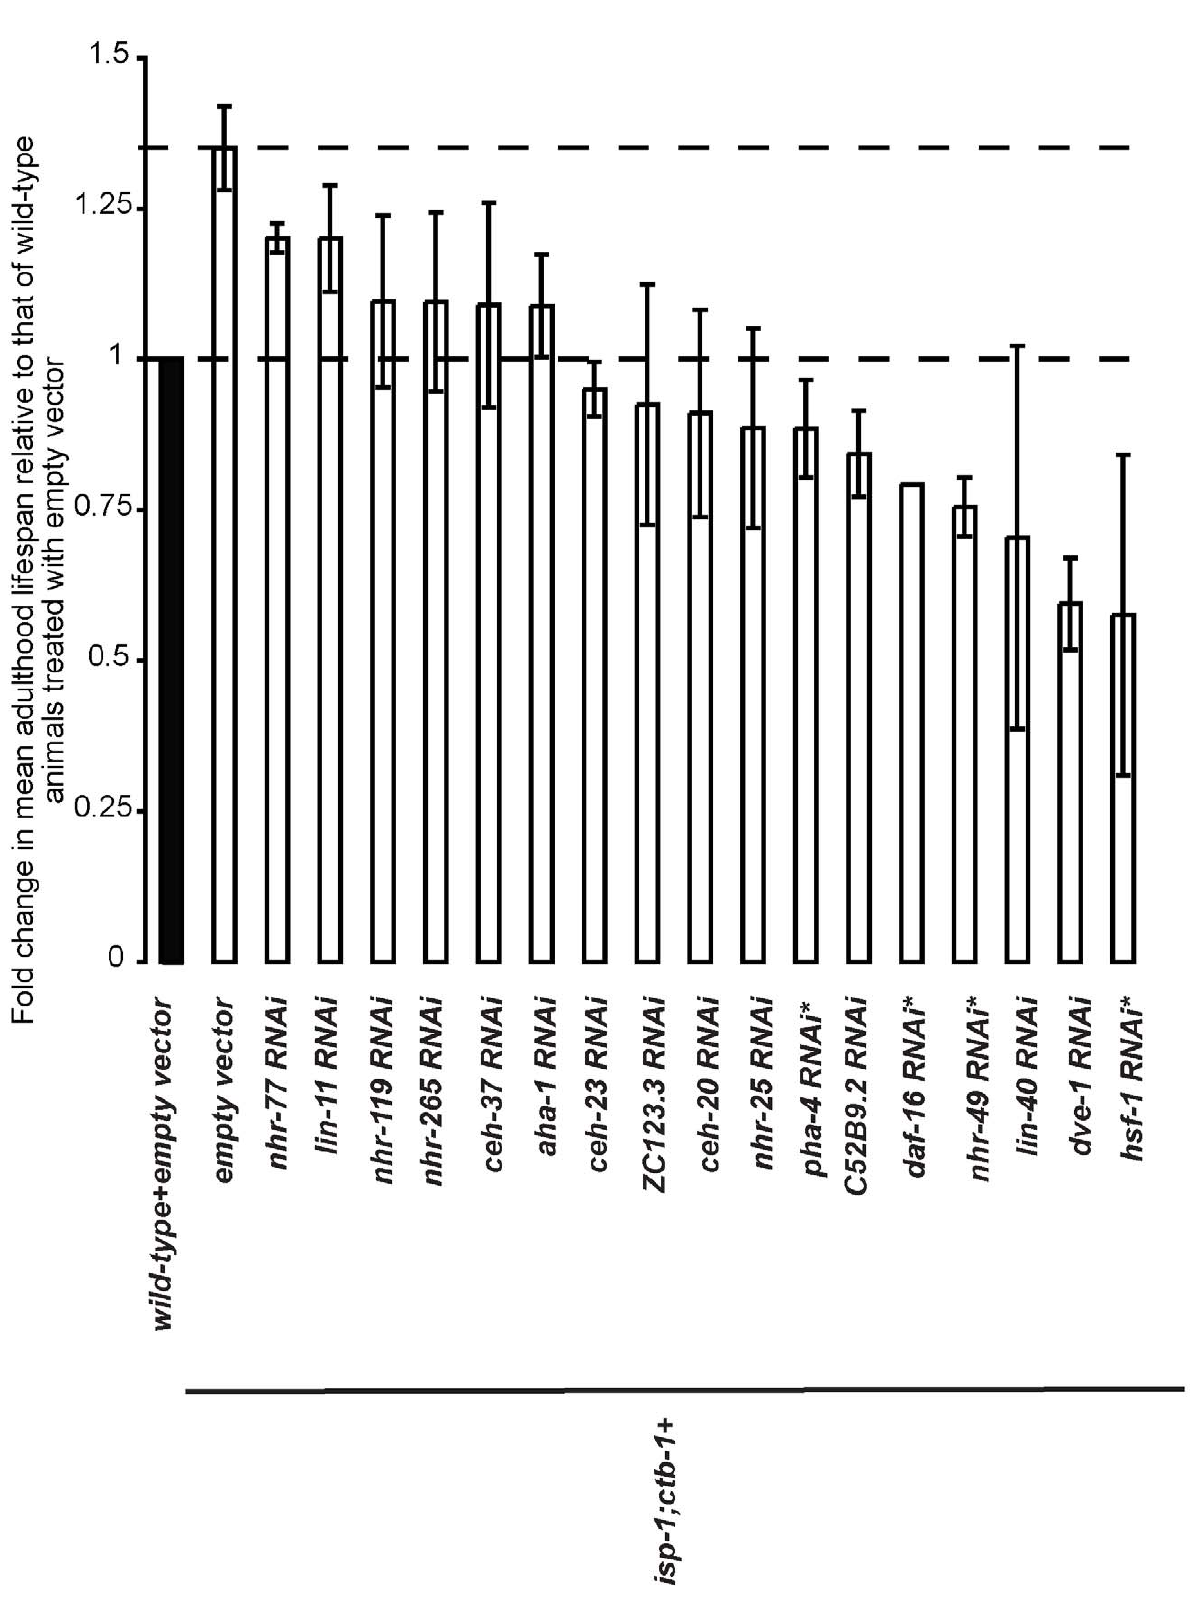
Figure 1. A targeted RNAi screen identifies 17 RNAi candidates that decrease the lifespan of the isp-1;ctb-1 mutant. The mean fold change in lifespan relative to that of wild-type worms treated with empty vector (black bar, value set to 1) was calculated for isp-1;ctb-1 mutant treated with empty vector or with each RNAi clone tested. The mean fold changes ( 6 s.d.) presented are averaged from at least three independent experiments. Only the RNAi clones that decrease the lifespan of the isp-1;ctb-1 mutant by at least 10% are represented (see Table 1). Among them, 13